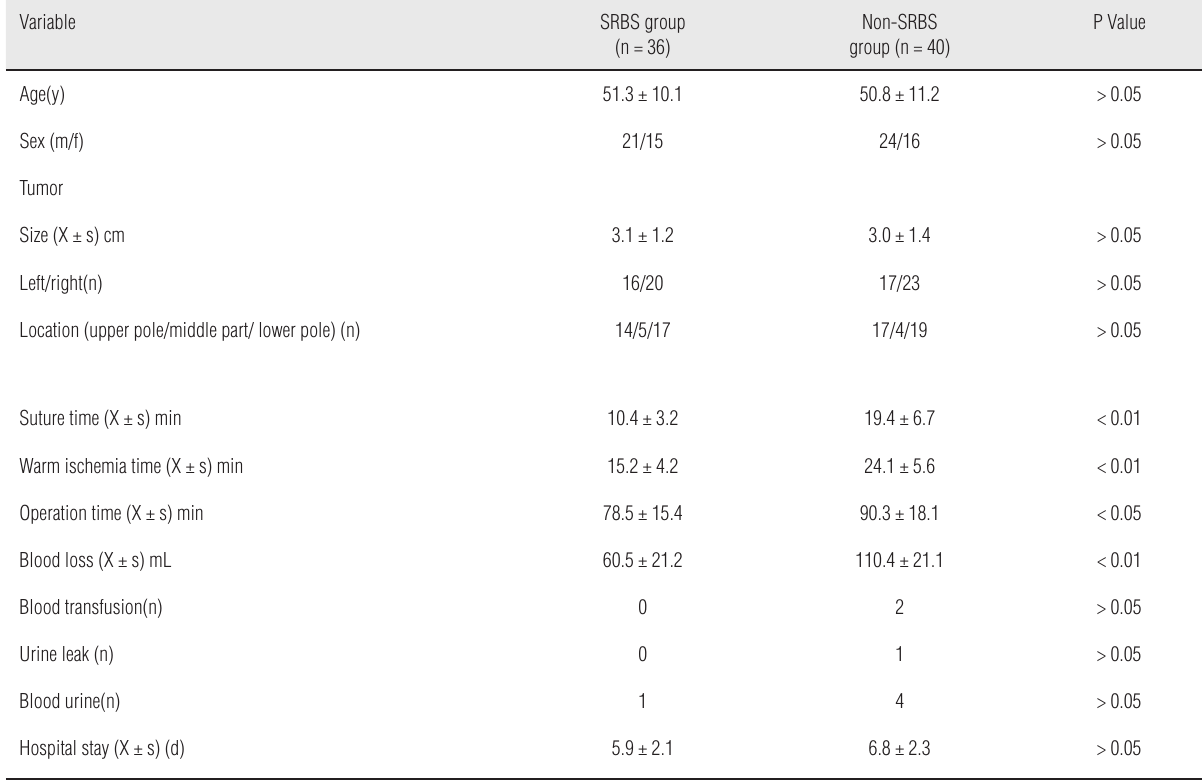
Table 1 - Comparisons between characteristics of operation and postoperative outcomes.